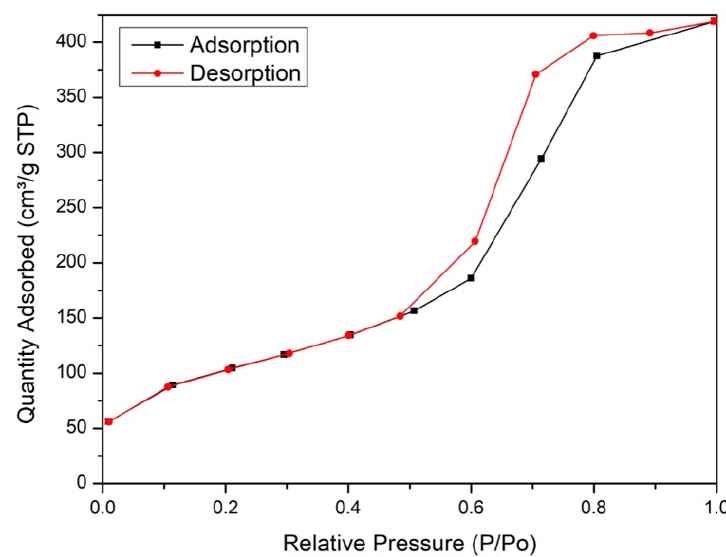
Figure 6. N adsorption-desorption isotherms of silica xerogel from corn husk. 2